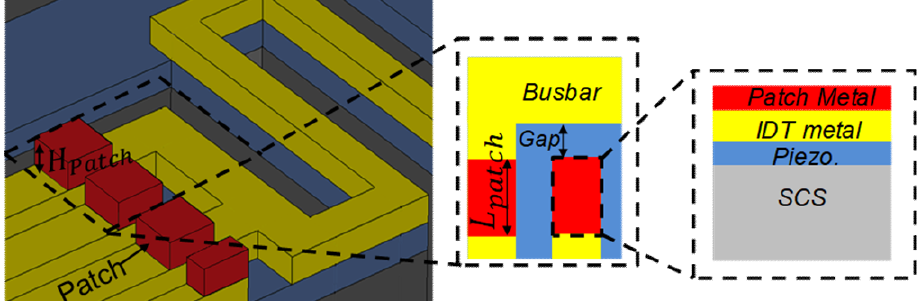
Figure 8. Schematic showing the proposed layout of metal patches on the edges of electrodes (inset: top view and side view of the selected regions at the edge of the IDT electrodes).